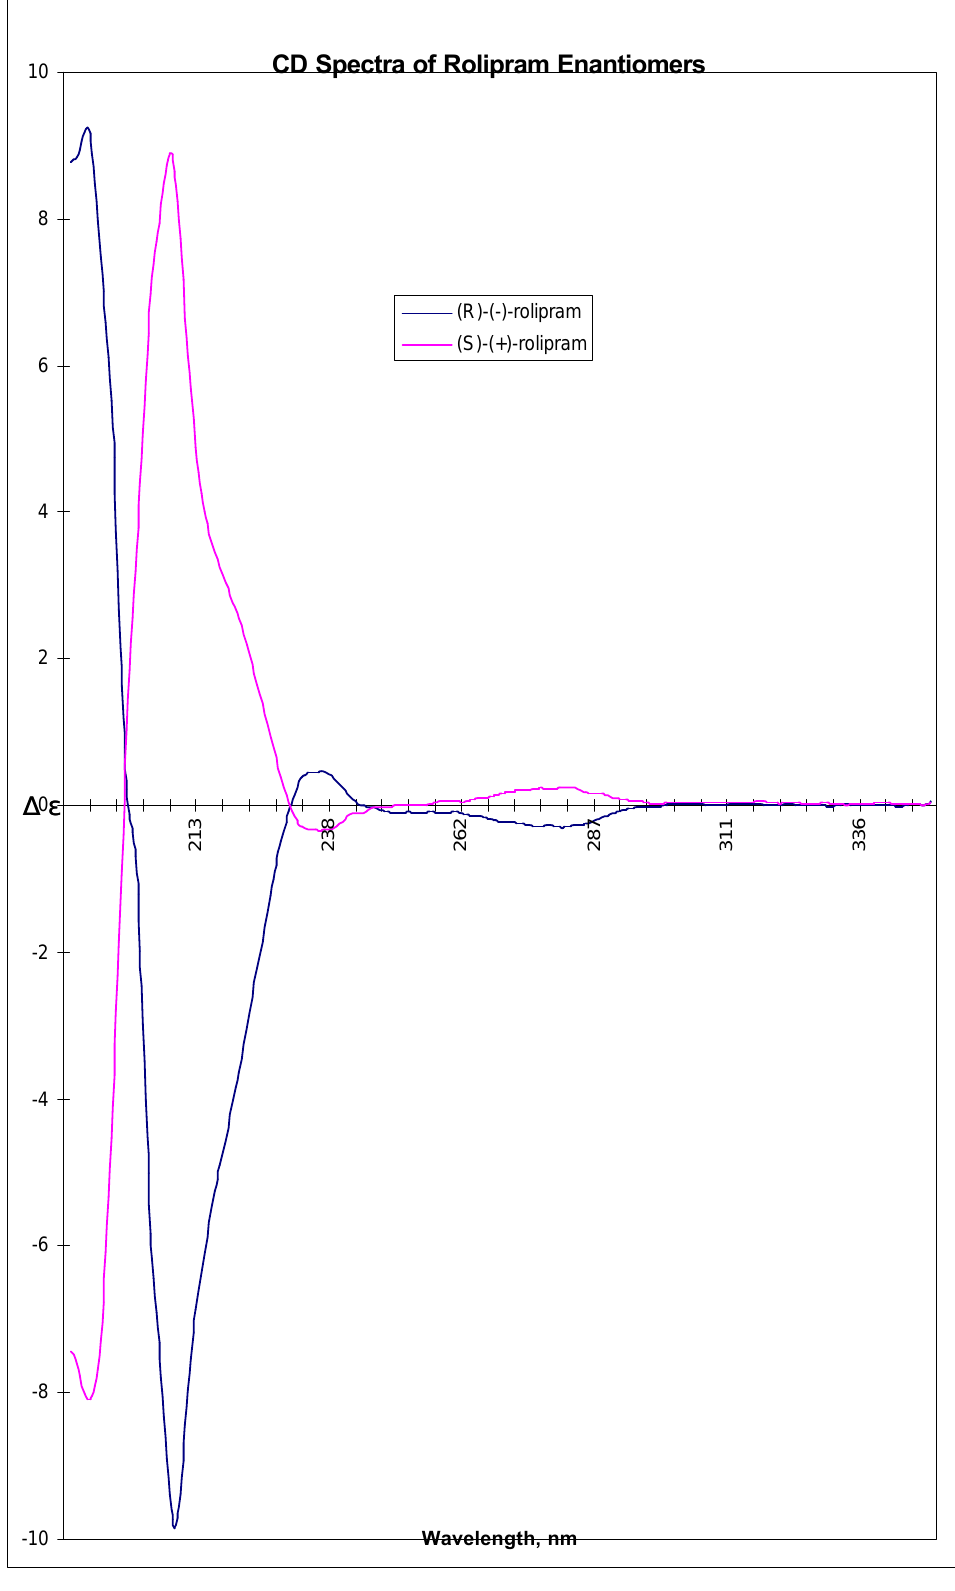
Figure 2. CD Spectra of the rolipram enantiomers. Conditions: c = 2.00 mg/ml, MeOH, l = 0.01